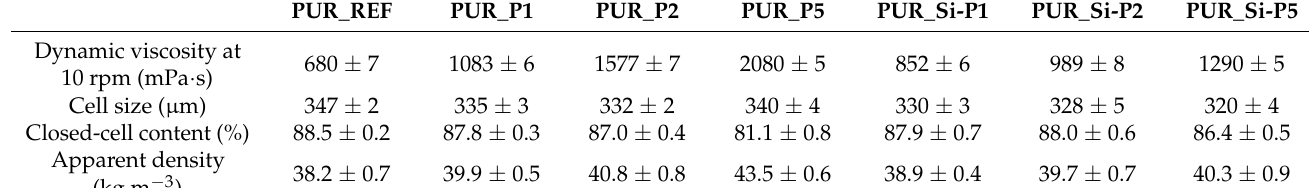
Figure 5. Cellular morphology of ( a ) PUR_REF, ( b – d ) PUR_P, and ( e – g ) PUR_Si-P.